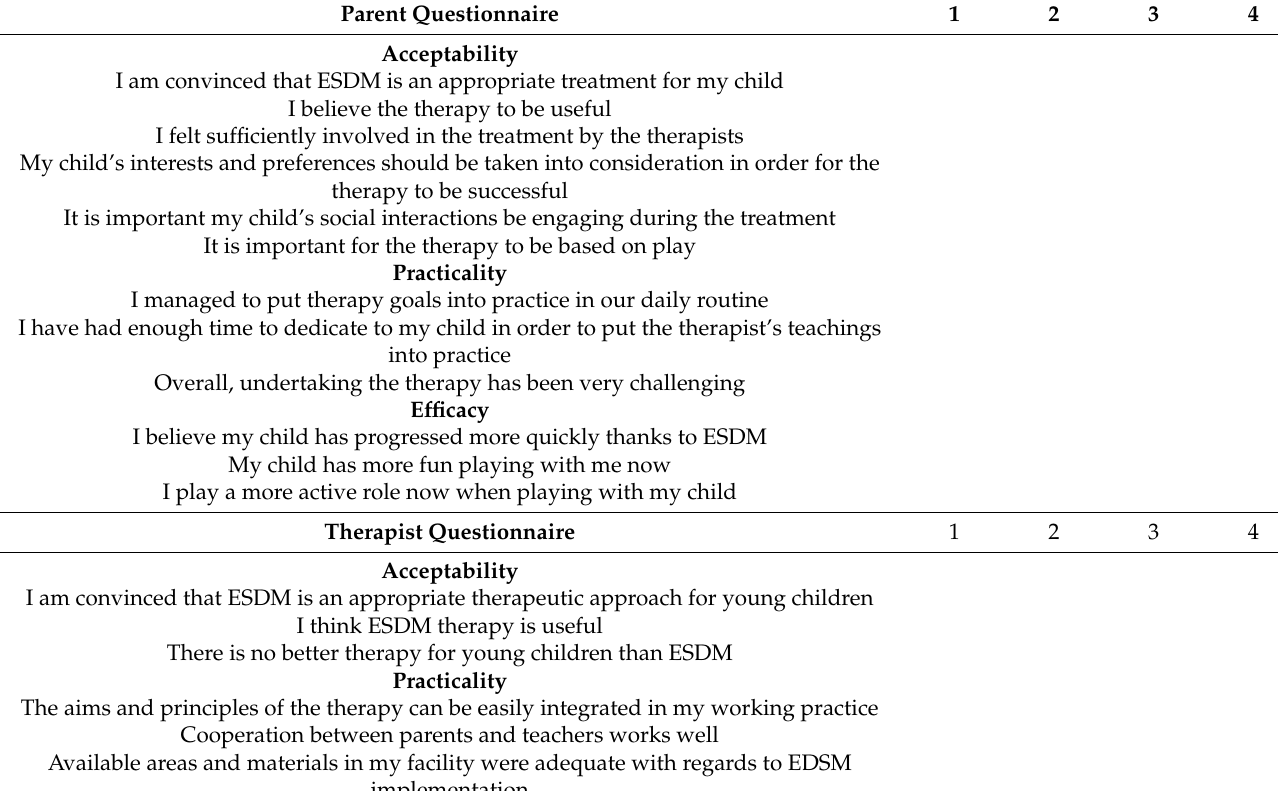
Table 2. Parent and therapist questionnaires to assess feasibility (1 = strongly disagree with the statement; 2 = slightly disagree with the statement; 3 = slightly agree with the statement; 4 = strongly agree with the